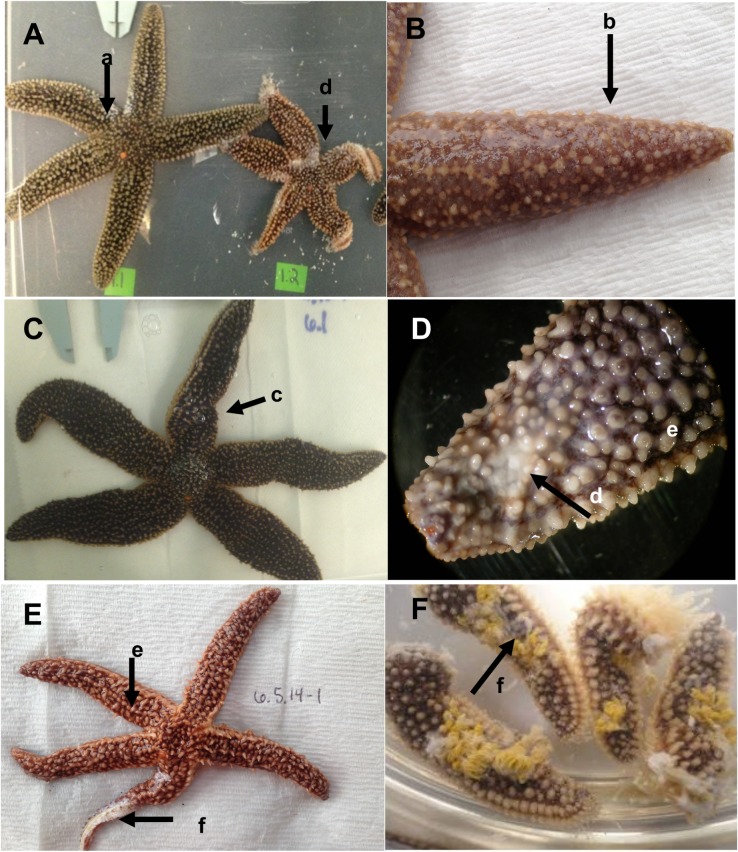
Gross morphological signs of Sea Star Wasting Disease.Representative images of A. forbesi affected with wasting disease showing combinations of different clinical signs (A-F). Clinical signs are indicated by arrows, and included (a) limb curling, (b) mucoid-like aboral surface coat, (c) pinching, (d) small ulcerations shown as white pinpoint lesions, (e) loss of spine orientation, and (f) severe ulcerations leading to exposure of underlying tissues.